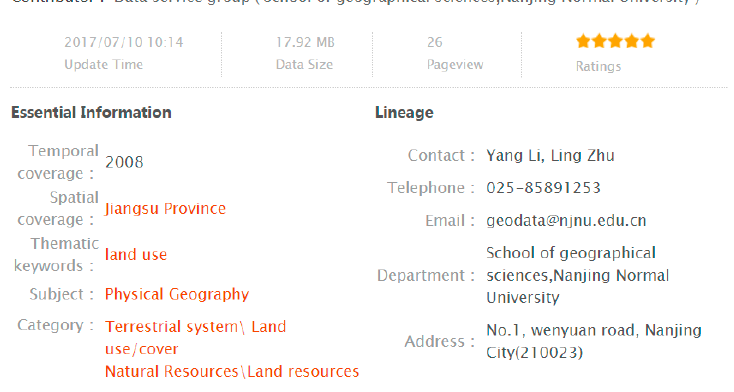
Figure 4. Parts of the metadata of a geospatial dataset in National Earth System Science Data Sharing Infrastructure (NESSDSI).